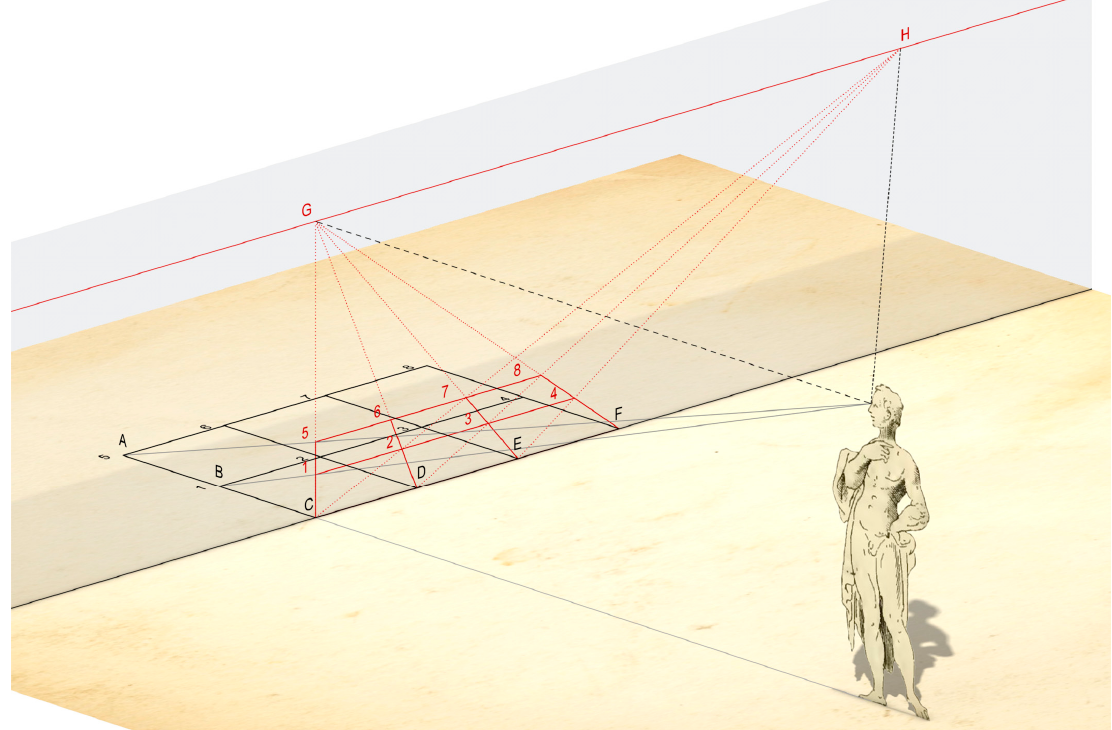
Figure 8. The digital model that illustrates the principles of the prospective representation outlined in the second